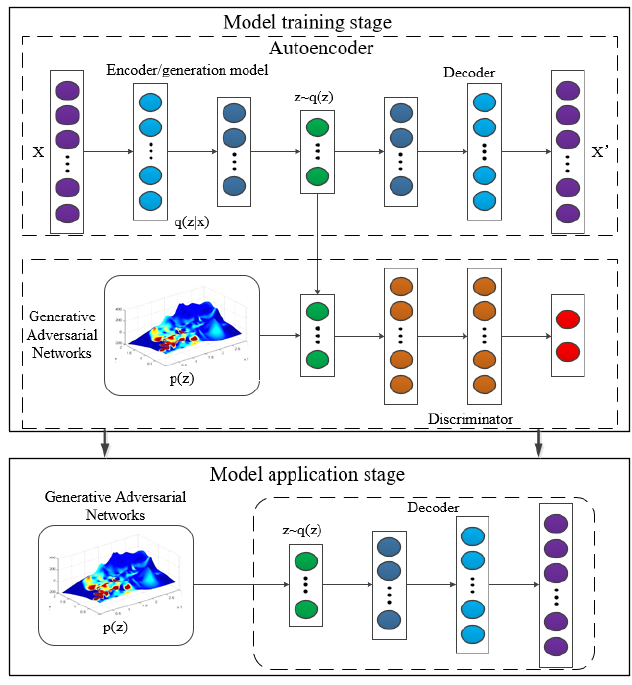
Figure 3. Adversarial autoencoder structure.